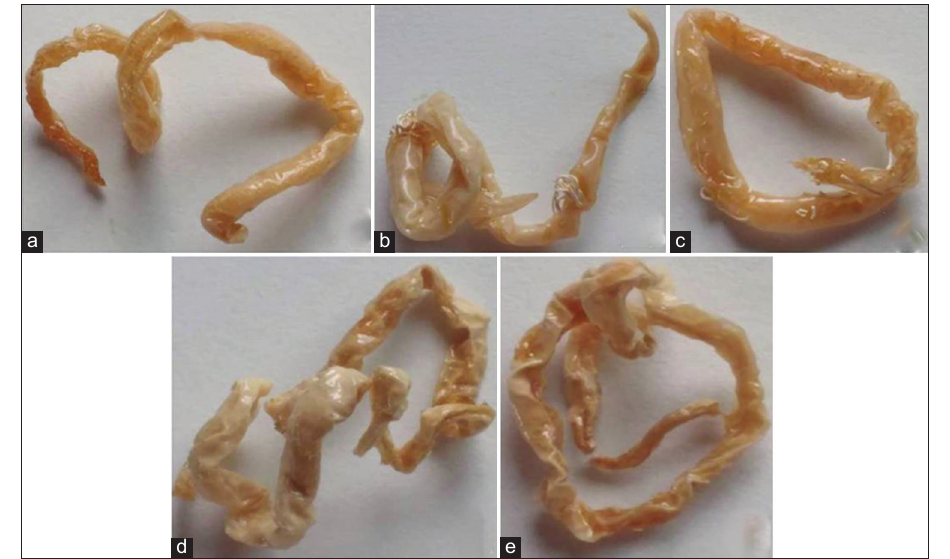
Figure-1: Toxocara vitulorum plastinated in melamine and turpentine oil with clove oil (MTCl) (a), chloroform (MTC) (b), xylene (MTX) (c), benzene (MTB) (d), and isopropanol (MTI) (e) polymer Table-1: Average score of the qualitative parameters of the plastinated model Toxocara ( Neoascaris ) vitulorum on 5-point scale. Parameters